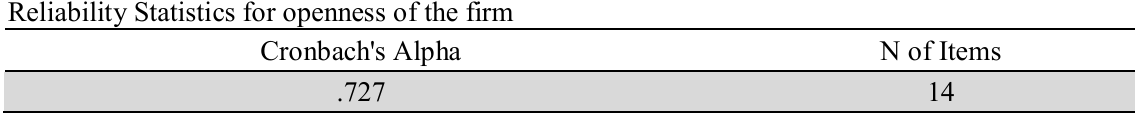
Reliability Statistics for openness of the